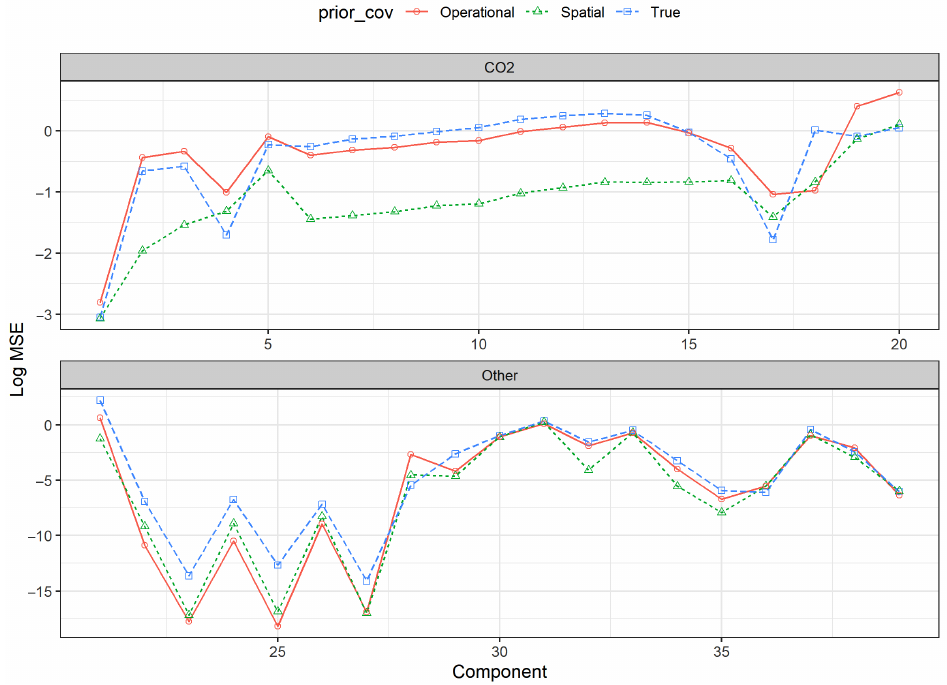
Figure 4. Log mean squared error (MSE) for the retrieval error of the state vector components, averaged across 100 samples and 64 locations per sample. State vector elements are grouped into the CO vertical profile ( top ) and all other elements ( bottom ). All results are for the October 2015 2 Lamont template.